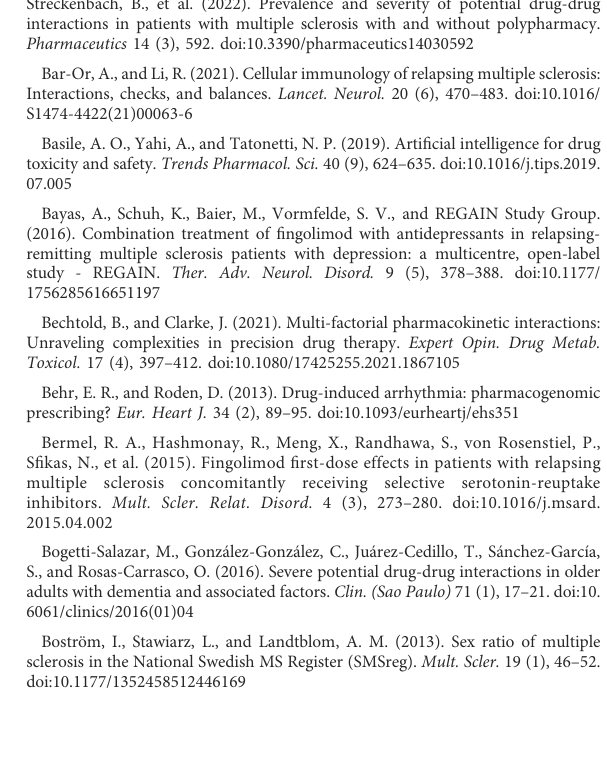
SUPPLEMENTAL FIGURE S1 Network visualization of severe potential drug-drug interactions detected in patientswithmultiplesclerosis.Atotalof1,684differentpDDIswererecorded forthe627patientsinthisstudy.Thisgraphshowsasubsetof336pDDIsthat were classi fi ed as severe in at least one of the three databases used. The interactions (edges) connect 164 different active drug ingredients (nodes), including7DMDsforMS.Thesizeofthenodescorrespondstothenumberof different pDDIs in which the drug is involved. The thickness of the edges indicates the frequency of the pDDIs in the patient cohort. The color of the edges indicates the consistency of the severity rating across the databases. DMD, disease-modifying drug; MS, multiple sclerosis; pDDI, potential drug- drug